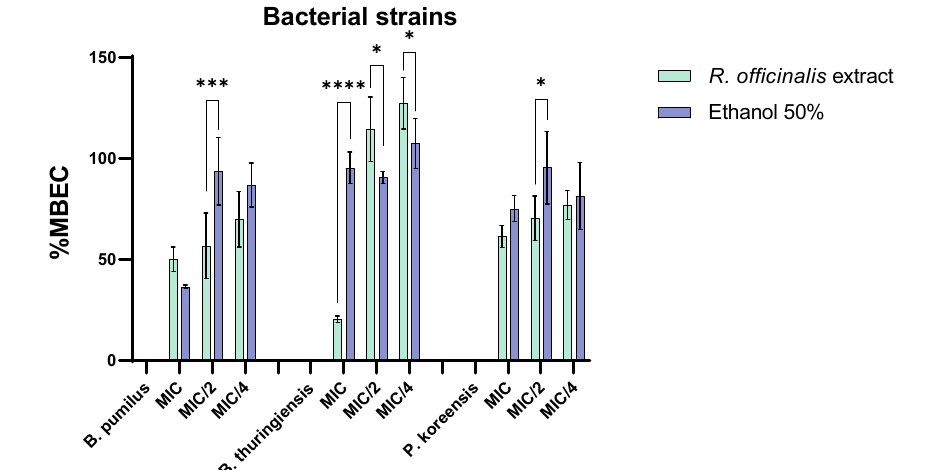
Figure 6. MBEC (%) values for R. officinalis extract and corresponding solvent concentration against bacterial biodeterioration strains (* p < 0.05, *** p < 0.001, **** p < 0.0001). The anti-biofilm effect seems to correlate, at least in some cases with the inhibition of the NO release (Table 4). Table 4. Comparative extracellular NO release (%) between R. officinalis extract and similar ethanol concentrations (mean ± SD).